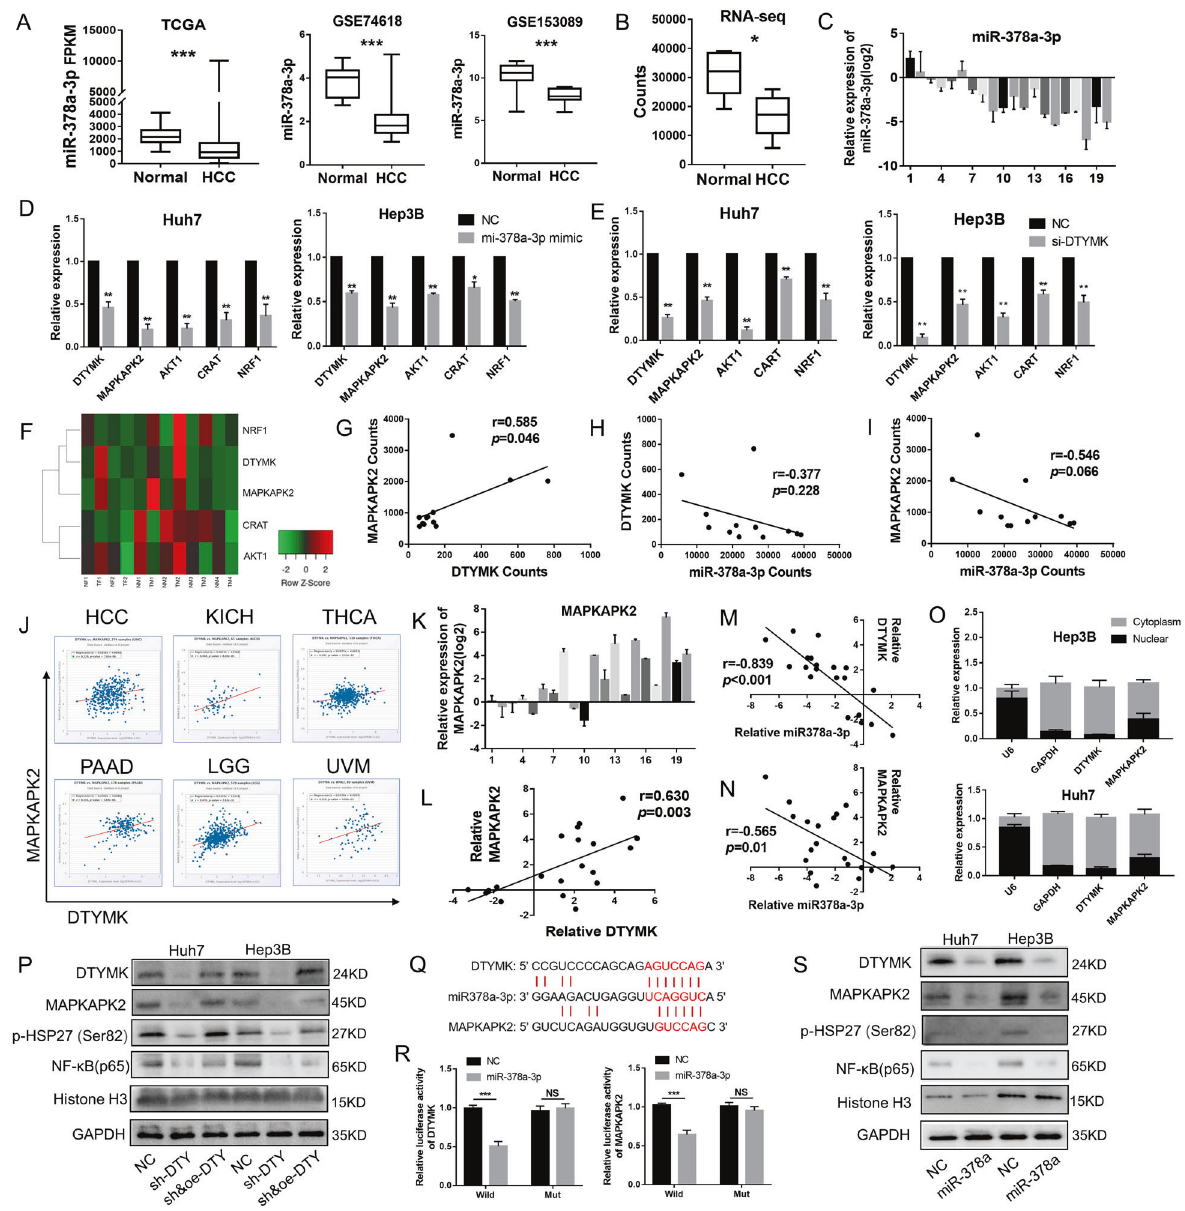
Fig. 3 DTYMK acted as ceRNA to affect the function of MAPKAPK2. A Decreased expression of miR-378a-3p in HCC from TCGA and GEO. B and C Decreased expression of miR-378a-3p in HCC from RNA-seq of 6 paired HCC tissues and qPCR of 20 paired HCC tissues. D Expression of DTYMK, MAPKAPK2, AKT1, CART, and NRF1 could be inhibited by miR-378a-3p. E Decreased expression of MAPKAPK2, AKT1, CART, and NRF1 after DTYMK knockdown. F Heatmap (RNA-seq) showed a clear correlation between DTYMK and MAPKAPK2. G Positive correlation between DTYMK and MAPKAPK2 (RNA-seq). H and I Opposite relation between miR-378a-3p, DTYMK, and MAPKAPK2 (RNA-seq). J Signi fi cant correlation between DTYMK and MAPKAPK2 in multiple cancer types. K and L Increased expression of MAPKAPK2 in 16 of 20 patients with HCC, which correlated with the expression of DTYMK. M An opposite expression trend existed between miR-378a-3p and DTYMK. N An opposite expression trend existed between miR-378a-3p and MAPKAPK2. O Subcellular locations experiments showing that DTYMK and MAPKAPK2 were enriched in the cytoplasm. P Decreased expression of MAPKAPK2 and p-hsp27, and decreased nuclear translocation of NF- κ B (p65) after DTYMK knockdown. Q Potential binding sites between DTYMK, MAPKAPK2, and miR-378a-3p. R MiR-378a-3p bound and signi fi cantly inhibited the expression of DTYMK and MAPKAPK2. S MiR-378a-3p inhibited the expression of DTYMK, thus inhibiting MAPKAPK2/p-hsp27/NF- κ B (p65). * p < 0.05; ** p < 0.01; *** p < 0.001. Increased expression of DTYMK was associated with a poor by NF-kB, in the negative control group (Fig. 4F). The statistical prognosis analyze of the IHC images is showen in Fig. 4G. The enzyme-linked A total of 105 HCC paraf fi n-embedded tissues obtained from the immunosorbent assay (ELISA) showed that the level of CCL5 in cell Sun Yat-sen University Cancer Center were used to perform supernatant decreased after DTYMK-knockdown (Fig. 4H). The immunohistochemical assays to detect protein levels of DTYMK in migration assay showed that CCL5 could stimulate the migration HCC tissues and adjacent nontumor tissues. The results showed of human monocyte cell line THP1 and CD14 + peripheral blood that the protein level of DTYMK was signi fi cantly upregulated in monocytes (PBMC) (Fig. 4I). Cell Death and Disease (2021)